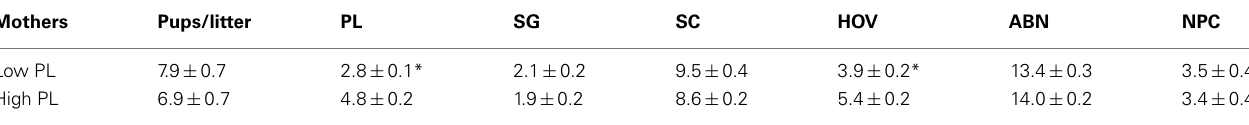
Table 1 | Low vs. high pup-licking mothers: means ( ± SEM) of pups/litter and maternal behaviors. Mothers